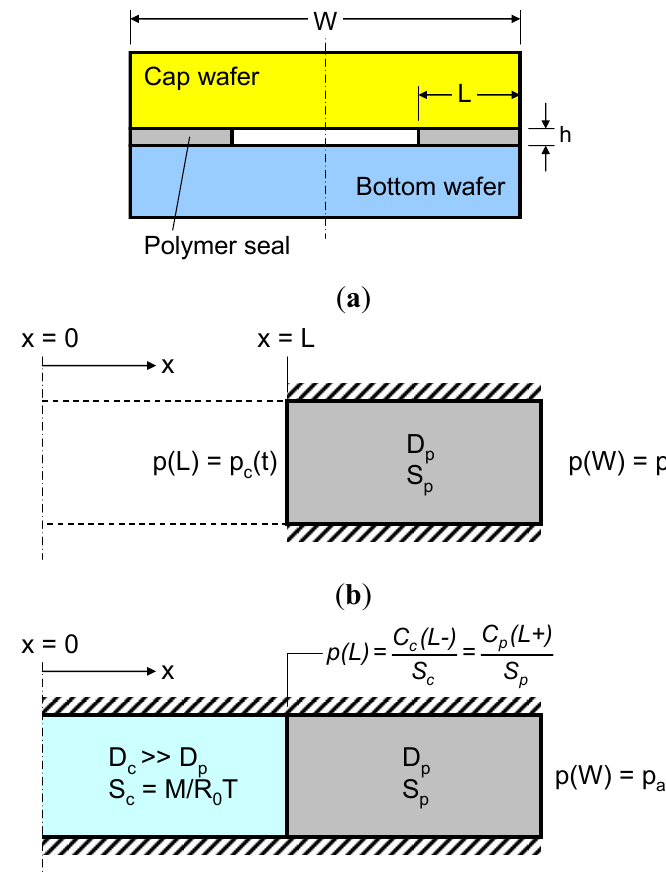
Figure 7. Schematic illustration of ( a ) the cross-section of the actual package, ( b ) the two-dimensional model and ( c ) the two-dimensional model with the “effective